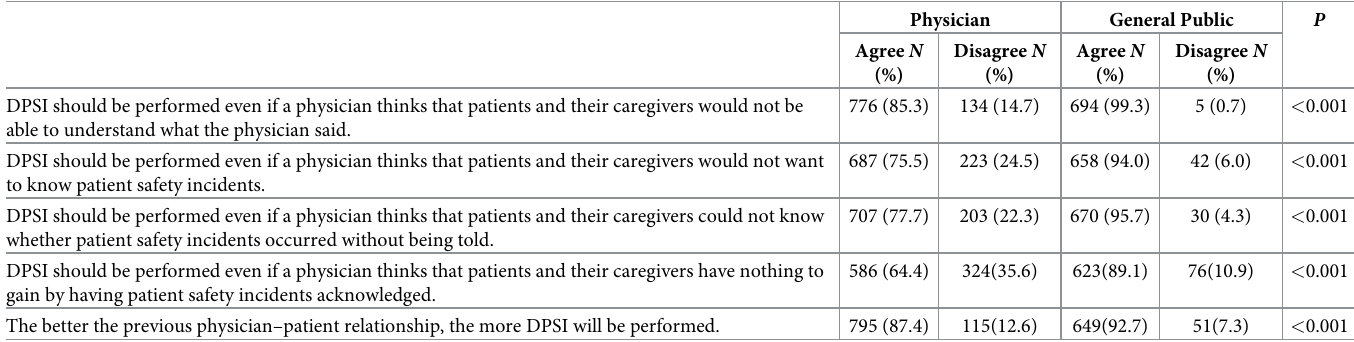
Table 3. Attitudes toward DPSI according to various scenarios in patient safety